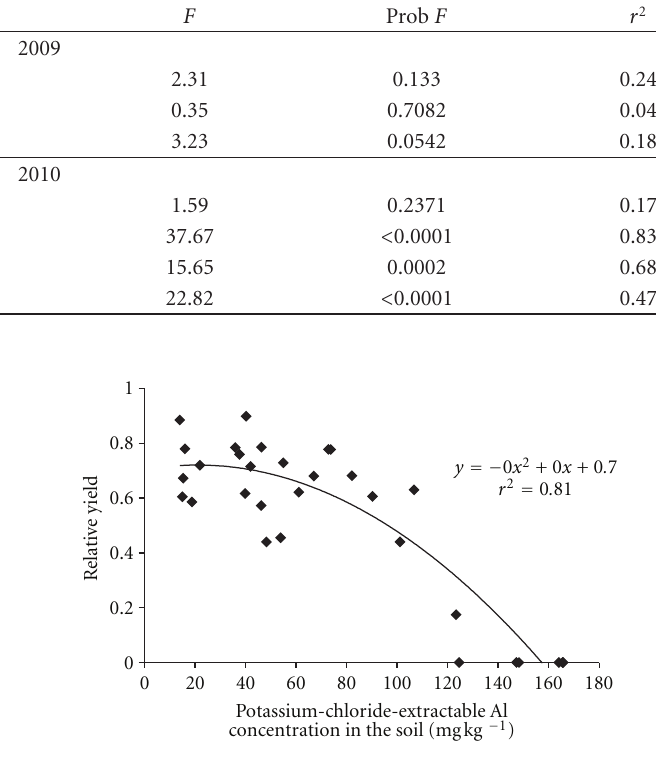
Figure 5: Relationship of grain sorghum relative yield and soil pH at Lahoma, Perkins, and Haskell, Oklahoma with yield plateau occurring at 0.90 with critical soil pH 5.42 (2009 and 2010).